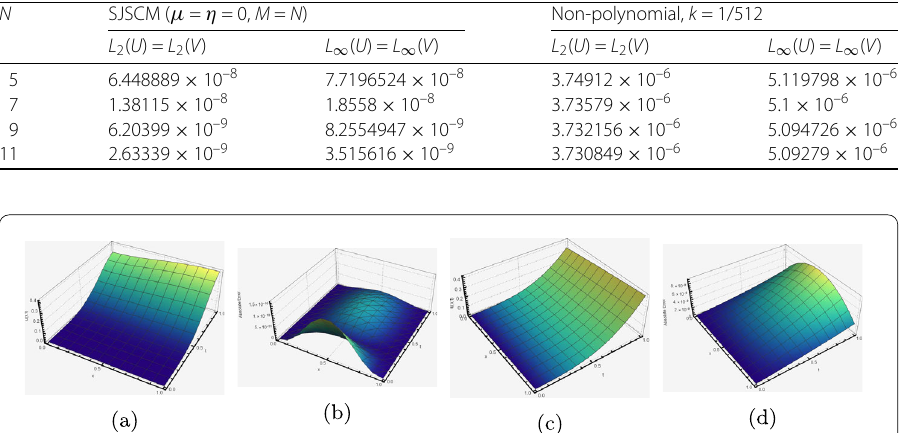
Table 9 L 2 and L ∞ error norms for u ( x , t ) = v ( x , t ) of Example 2 when 0 ≤ x ≤ 1, α 1 = α 2 = 0.5 N